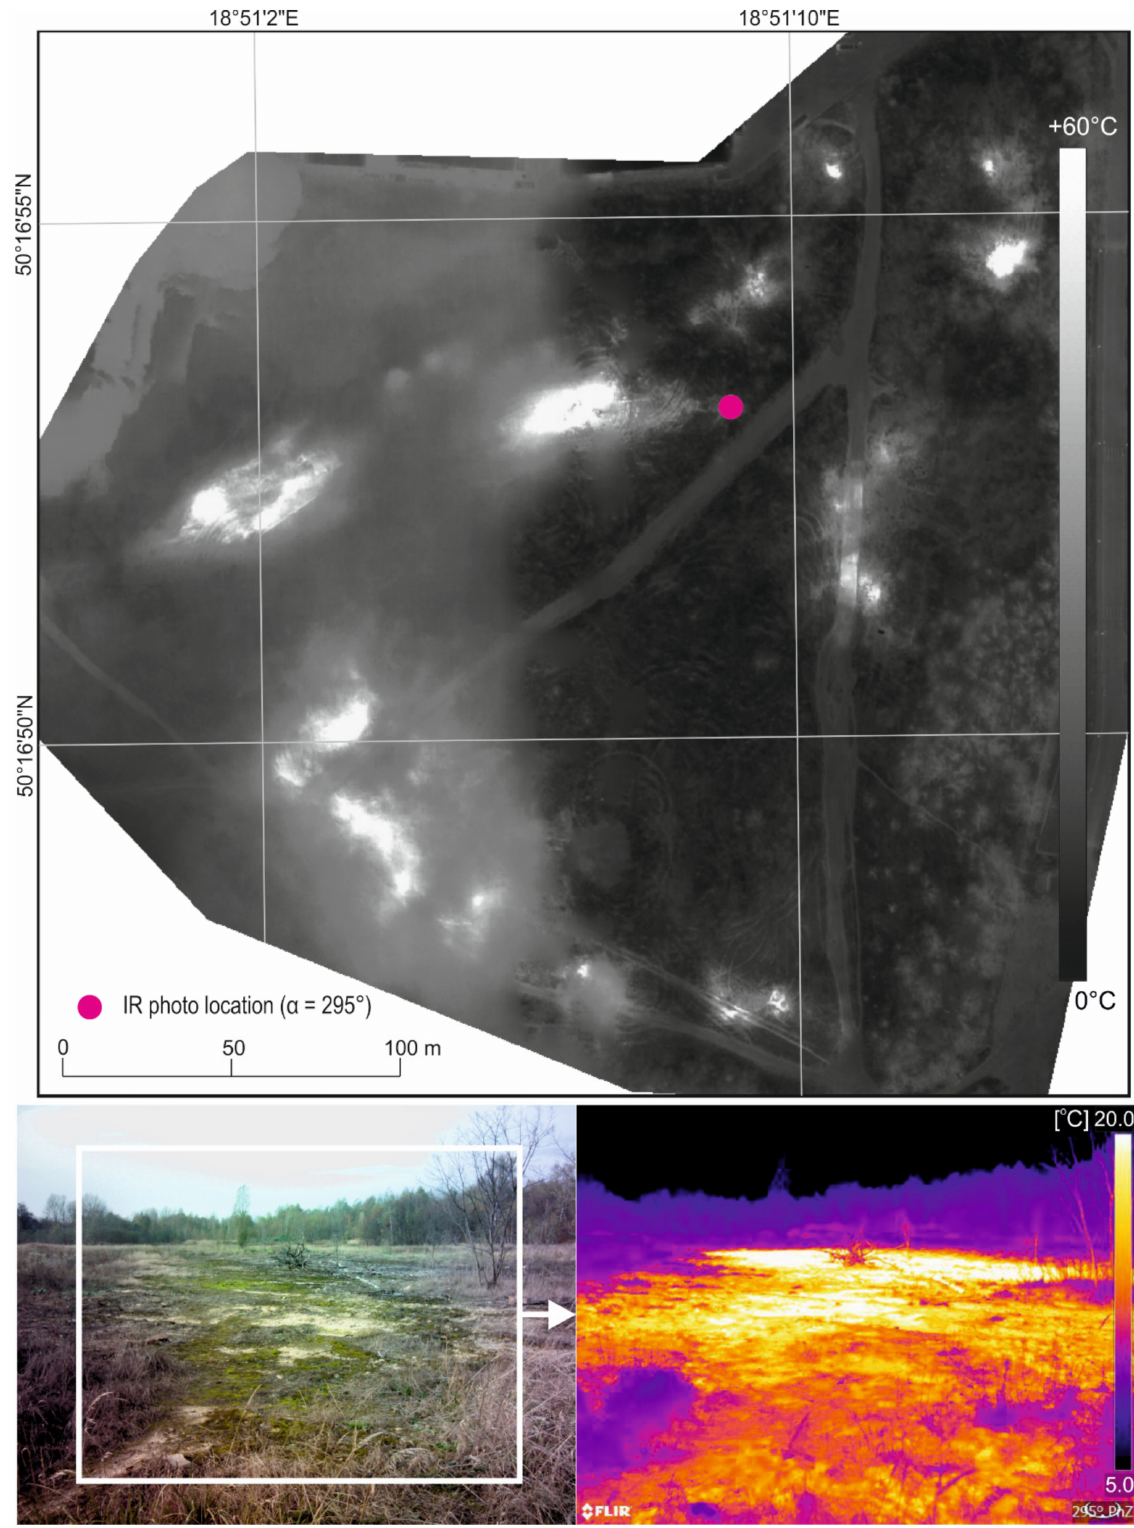
Figure 4. Thermal map (29 March 2019) and infrared photo (2 November 2019) of the D-RS-1 coal-waste